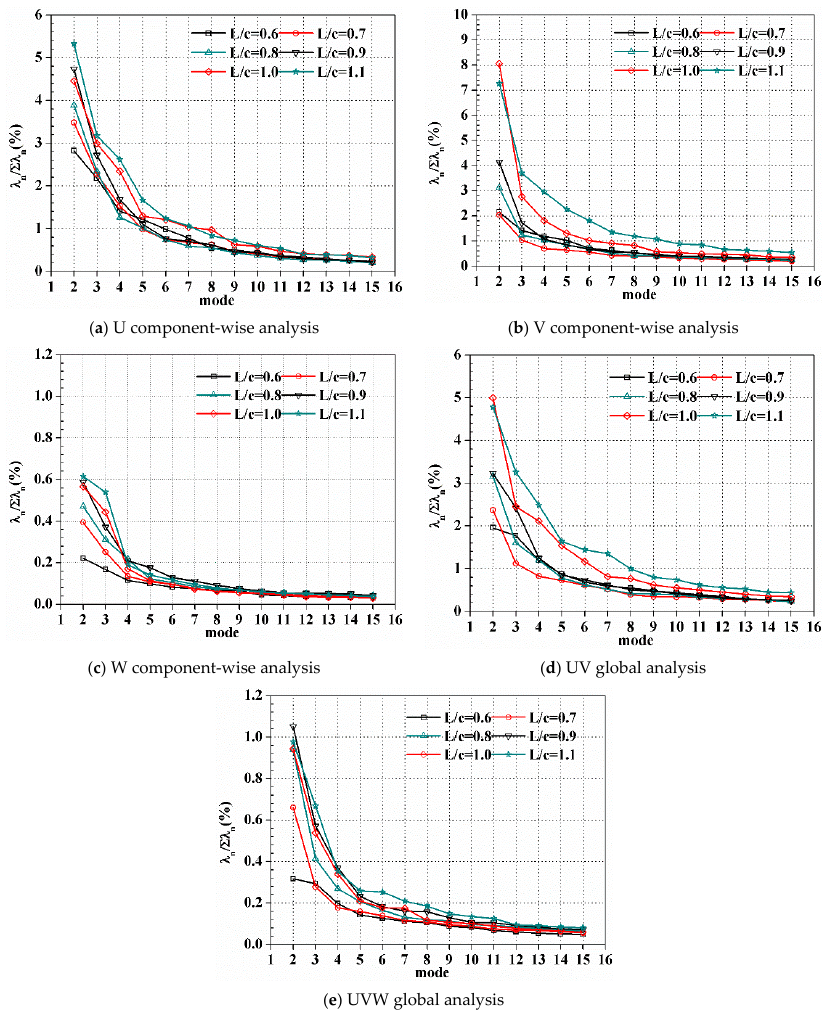
Figure 17. Relative energy of modes higher than 2 from all five different decomposition dimensionalities. To further study the impact of decomposition dimensionalities in the high-order modes, the velocity correlation coefficients account for correlation of each mode from different decomposition dimensionalities are shown in Figure 18.The correlation coefficients of the 2nd POD mode are nearly 1, which verified that the 2nd POD mode is unaffected. The correlation coefficients of modes order higher than 3 are weak. In all, the three different decomposition dimensionalities lead to almost the same 2nd mode while significant difference can be observed in modes which order are higher than 2.